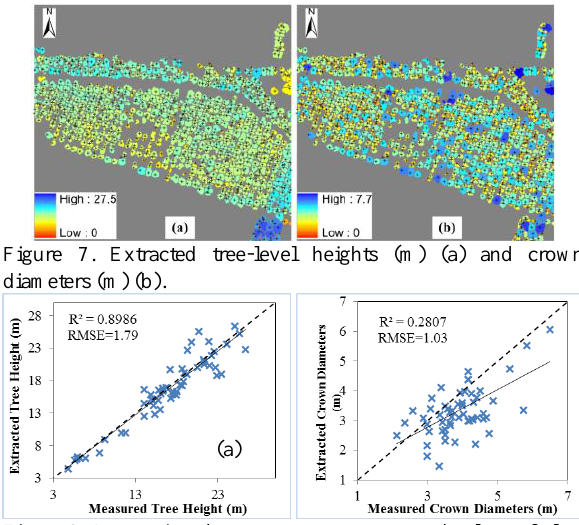
Figure 8. Comparison between average measured values of plot- level tree structural parameters and estimates derived from LiDAR data: (a) tree heights, (b) crown diameters.